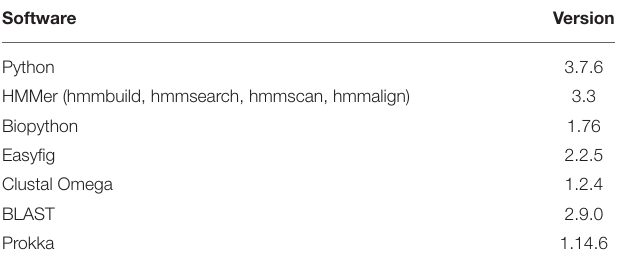
TABLE 1 | Software dependencies and versions implemented in